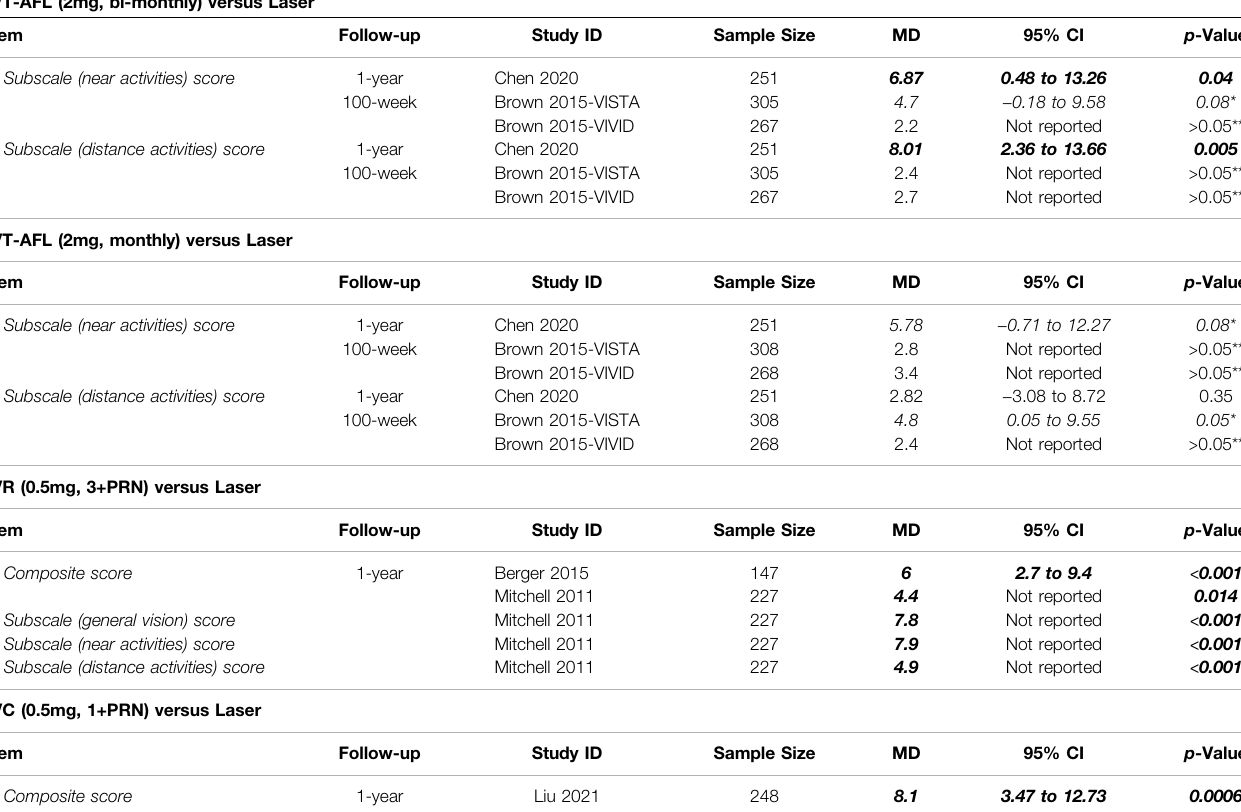
TABLE 5 | Quality of life assessed by NEI VFQ-25, high =